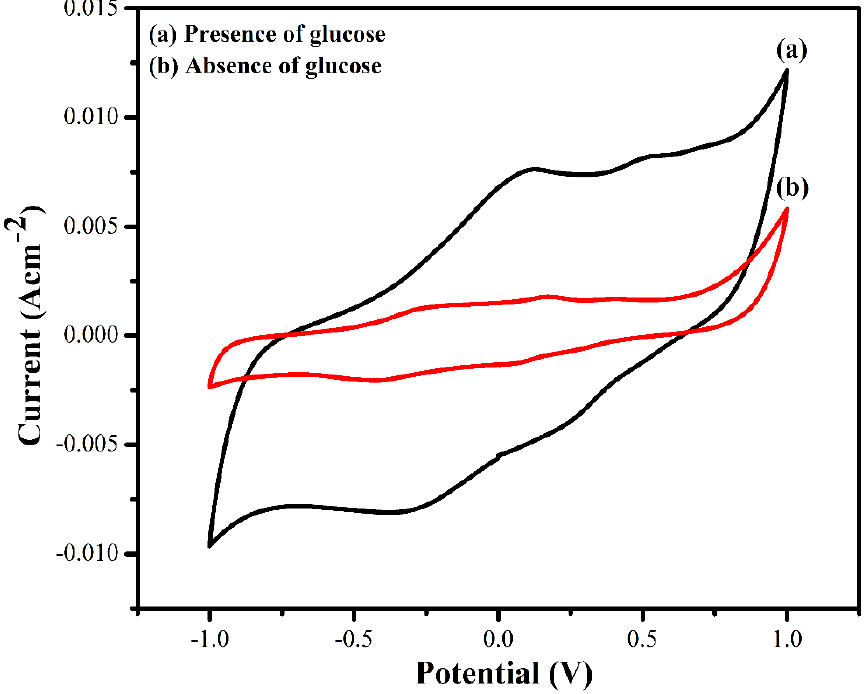
Figure 9. Cyclic voltammograms of GCE/(MWCNT/ZnS/AgNWs/PANI/Frt/GOx: ( a ) in presence of 50 mM glucose concentration; ( b ) absence of glucose.